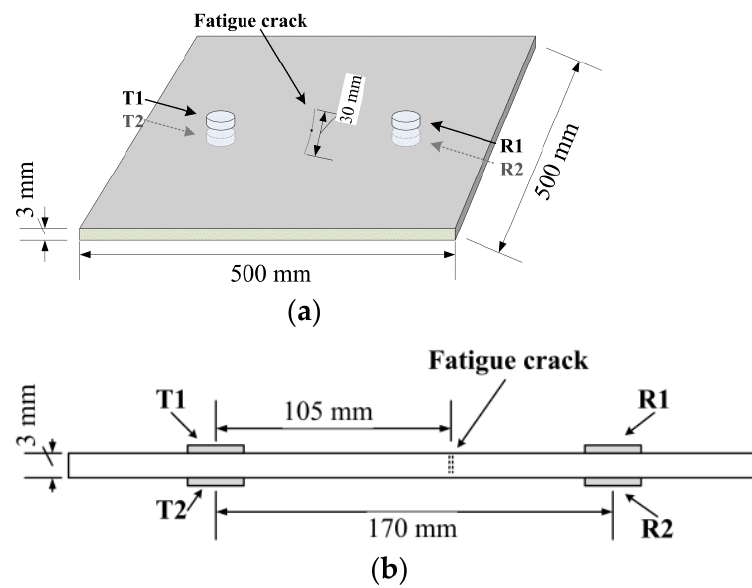
Figure 4. Schematic diagram of the experimental setup: ( a ) top view ( b ) front view. Four identical piezoelectric discs (APC 851) were installed on the specimen, whose diameter and thickness was 6.6 mm and 0.24 mm, respectively. A dual-PZT scheme was applied to generate and receive selective symmetric and antisymmetric modes.